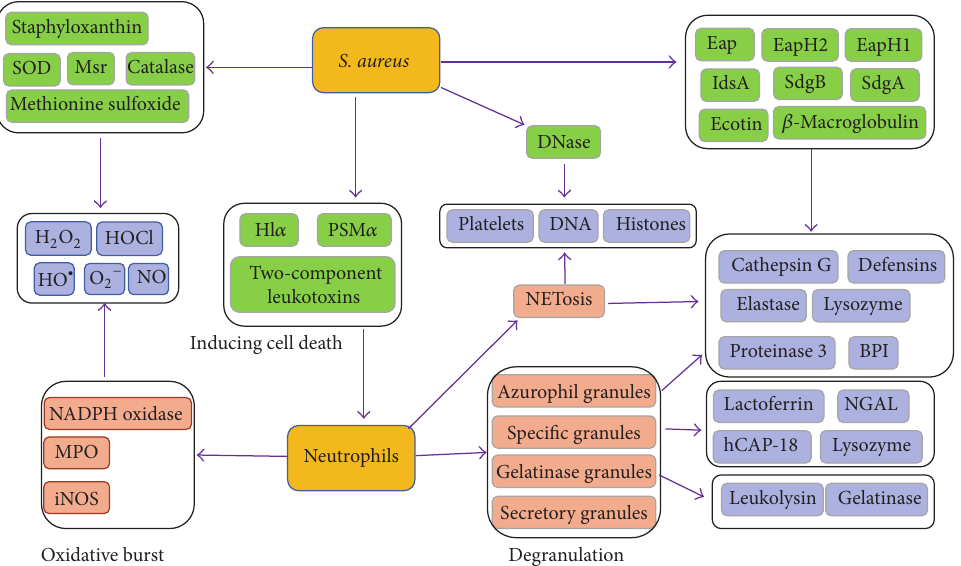
Figure 3: Direct antimicrobial mechanisms from neutrophils and the S. aureus counterattack. Neutrophils are equipped with multiple anti- infective strategies including the bacterial uptake (phagocytosis), the phagolysosomal degradation of bacteria via reactive oxygen species (oxidative burst), the release of antimicrobial molecules (degranulation), and the formation of a web-like structure composed of chromatin, histones, and antimicrobials (neutrophil extracellular traps, NETs). S. aureus is equipped with a magnitude of neutrophil resistance factors (green boxes) allowing the pathogen to uniquely counteract each antibacterial strategy of neutrophils.